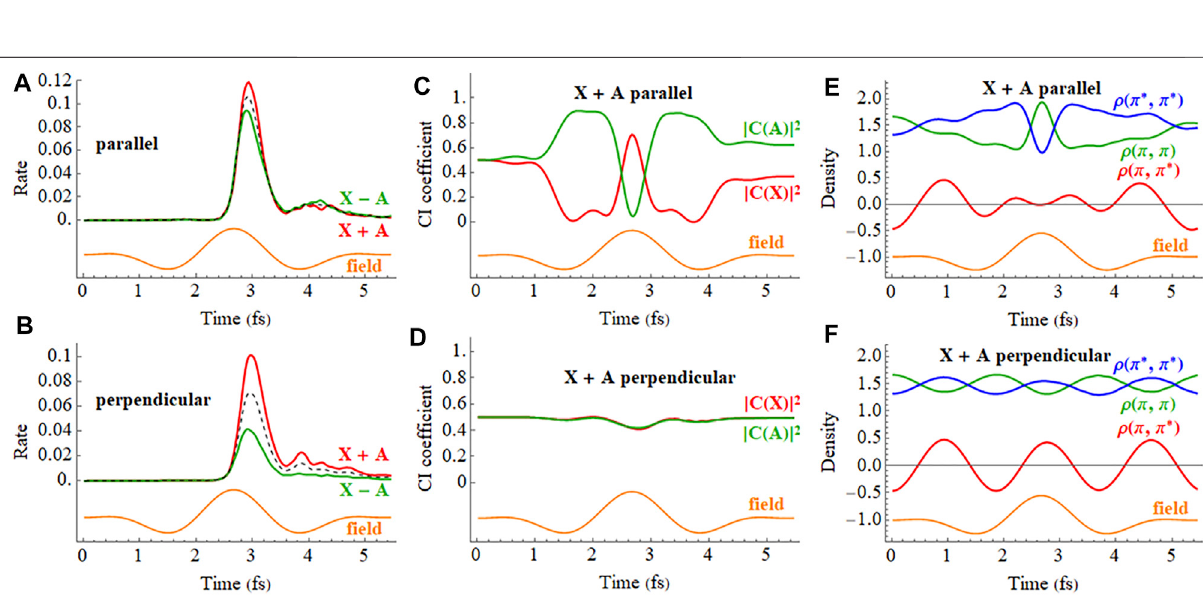
FIGURE10|(A,B) IonizationrateforcoherentX+AandX − Asuperpositionsfora2cycle,800 nmlinearlypolarizedpulsewith E max =0.075aualignedparalleland perpendicular to the molecular axis (incoherent average of X and A in black dashed). (C,D) CI coef fi cients for the X and A con fi gurations (red and green, resp.) in the normalizedwavefunctionforpolarizationsparallelandperpendiculartothemolecularaxis. (E,F) Densitymatrixelementsforthe π x and π p x orbitalsforpolarizationsparallel andperpendiculartothemolecularaxis(theorangetracesareproportionaltotheelectric fi eld). AmovieoftheX+Aholedensity forapulseparalleltothemolecular axis is available in Supplementary Figure S3 of the Supporting